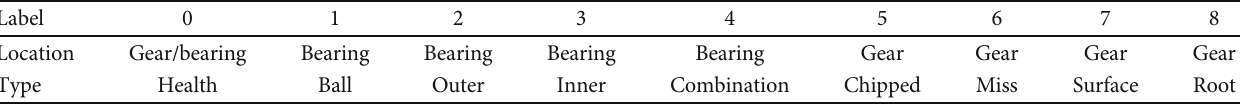
Figure 10: Visualization of features for CRWU dataset of task 3 ⟶ 0 : (a) CNN source; (b) CNN target; (c) DAN source; (d) DAN target; (e) JAN source; (f) JAN target; (g) CORAL source; (h) CORAL target; (i) DANN source; (j) DANN target; (k) WDATL source; (l) WDATL target. Table 5: The description of the SEU dataset.